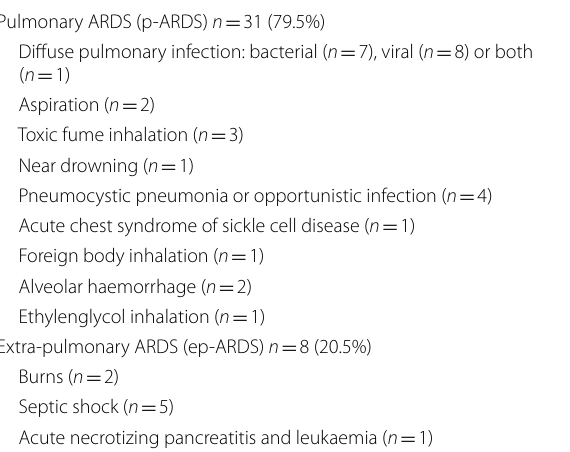
Table 1 Aetiology of ARDS of the 39